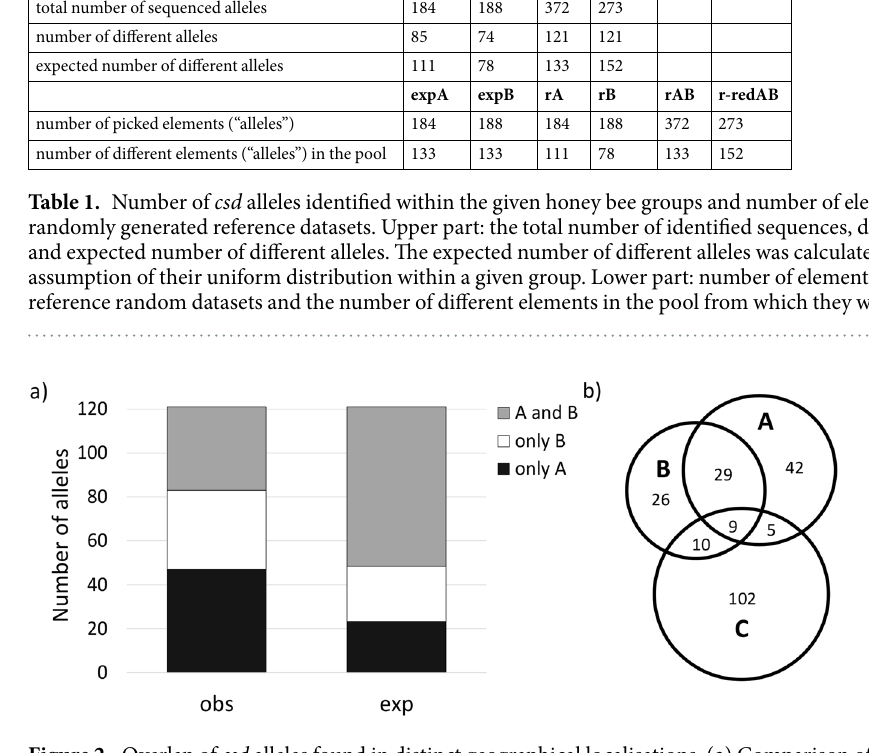
Figure 2. Overlap of csd alleles found in distinct geographical localisations. ( a ) Comparison of the overlap of csd alleles in the analysed groups (obs) with the overlap expected from the randomly generated groups of alleles (exp). The obs and exp distributions were compared using the chi-test and were found to be significantly different. ( b ) Venn diagram representing the overlap of csd alleles between the groups analysed in this study (A and B) and the set of 126 non-identical alleles described by Lechner et al . (C) 18